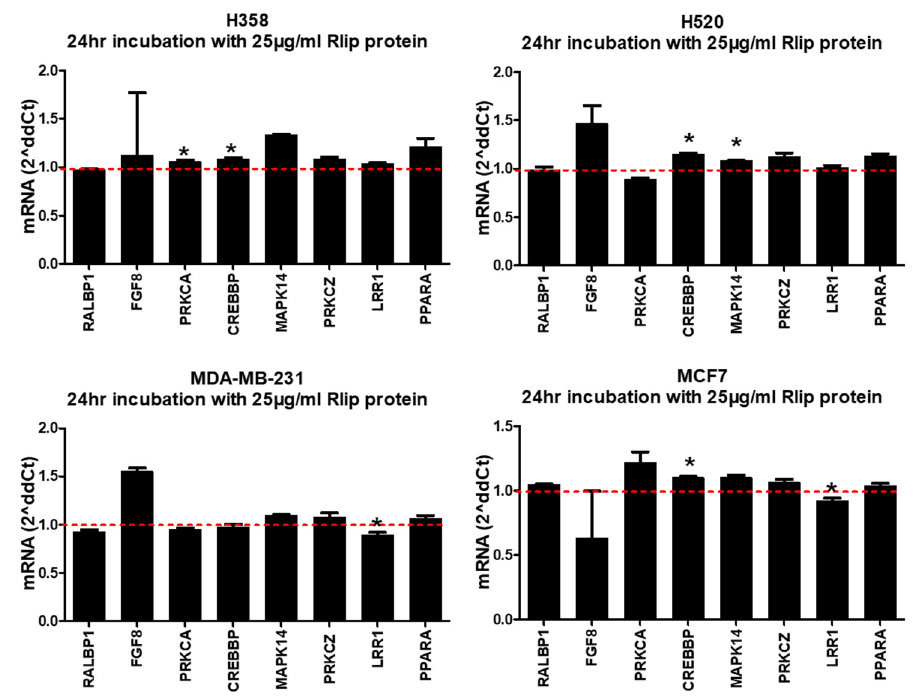
Figure 3. Addition of purified recombinant Rlip protein minimally alters transcription. Cells were collected 24 h following addition of 25 µg/mL (50 µg in 2 mL growth medium) purified GMP-grade recombinant Rlip protein in PBS. The results are shown as the fold-change of expression of Rlip- treated cells relative to PBS-treated controls, which were defined as 1 (indicated by red dotted lines). Asterisks ( * ) indicate p < 0.05 by Student’s t- test when comparing mRNA expression from each Rlip protein treatment to its corresponding PBS control treatment. Error bars indicate SEM ( n = 3).